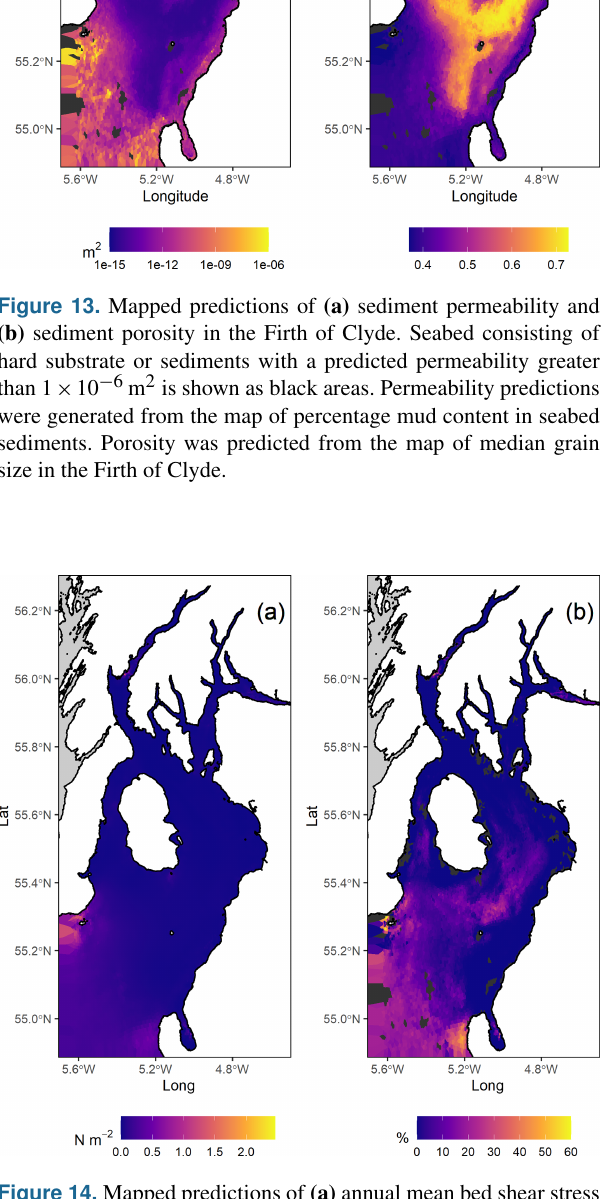
Figure 14. Mapped predictions of (a) annual mean bed shear stress and (b) sediment mobility in terms of the annual percentage of time that sediment motion occurs in the Firth of Clyde.